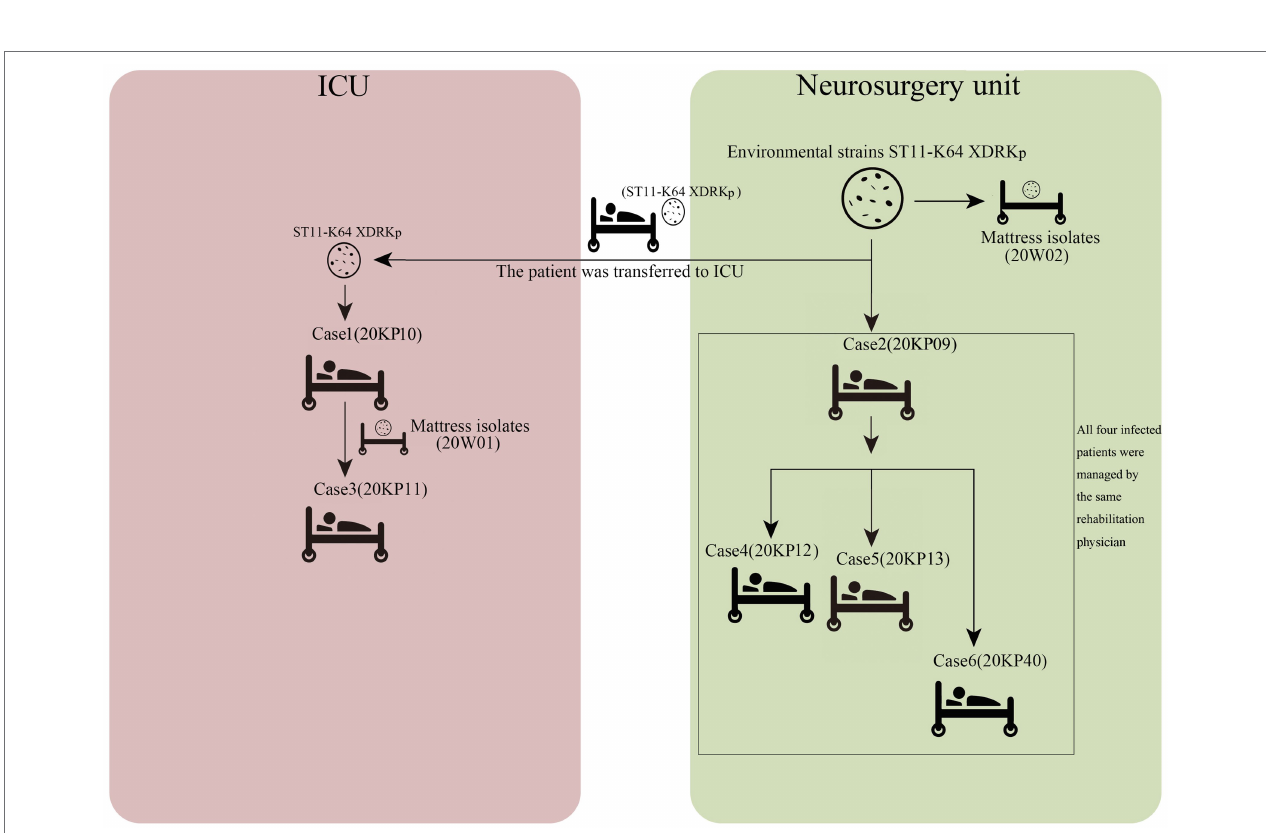
FIGURE 5 | Transmission chain of eight XDRKp